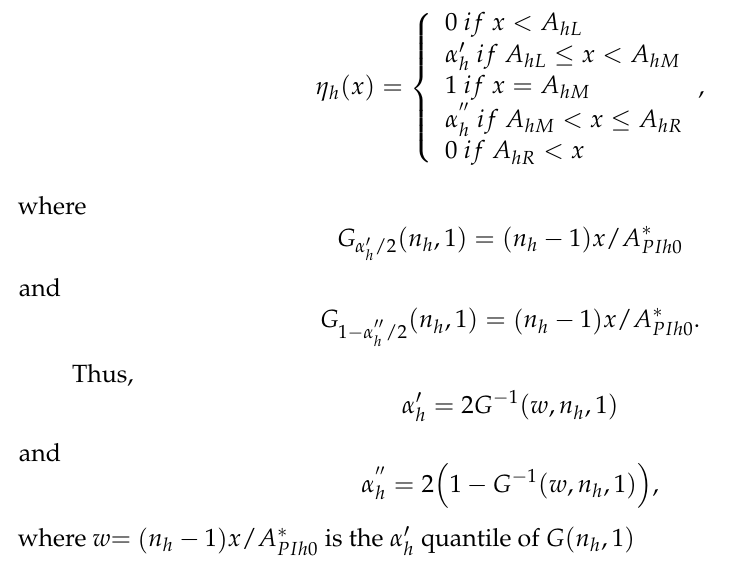
Figure 1. Schematic diagram of fuzzy membership function η 1 ( x ) before improvement and fuzzy membership function η 2 ( x ) after improvement.